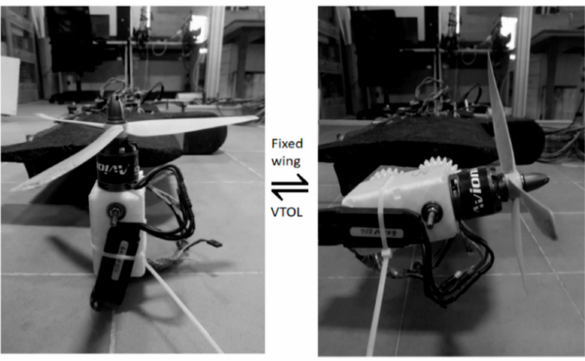
Figure 18. Fabricated prototype of the motor pod (Version1).